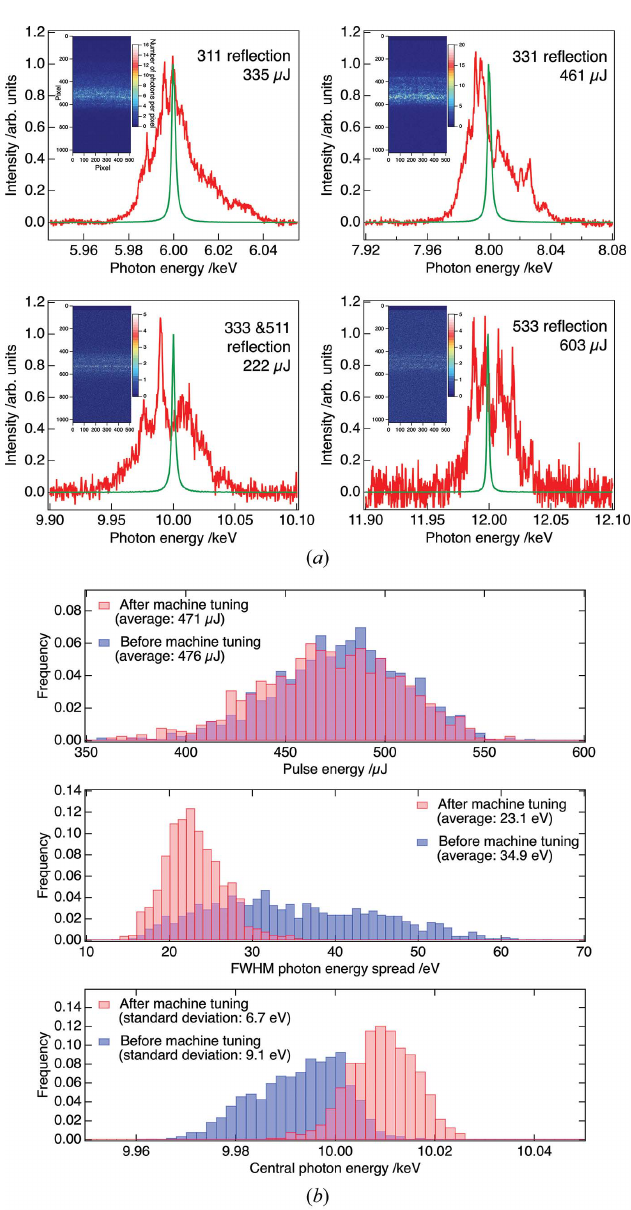
Figure 2 ( a ) Single-shot spectra of XFEL pulses measured with the spectrometer (red curves). Corresponding reflection index, pulse energy and diffraction image measured with the MPCCD detector are shown in each plot. Green curves represent average spectra of monochromated XFEL pulses ( (cid:2) E mono / E = 1.3 (cid:6) 10 (cid:4) 4 ) measured with the spectrometer. ( b ) Histograms of photon parameters (pulse energy at the optics hutch, photon-energy spread and central photon energy) of 10 keV XFEL pulses before and after machine